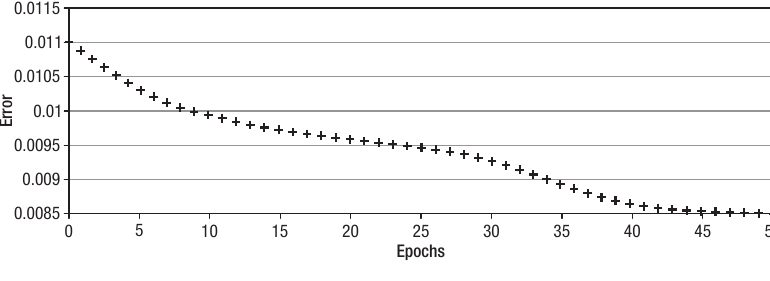
Fig. 5. Trend of errors during